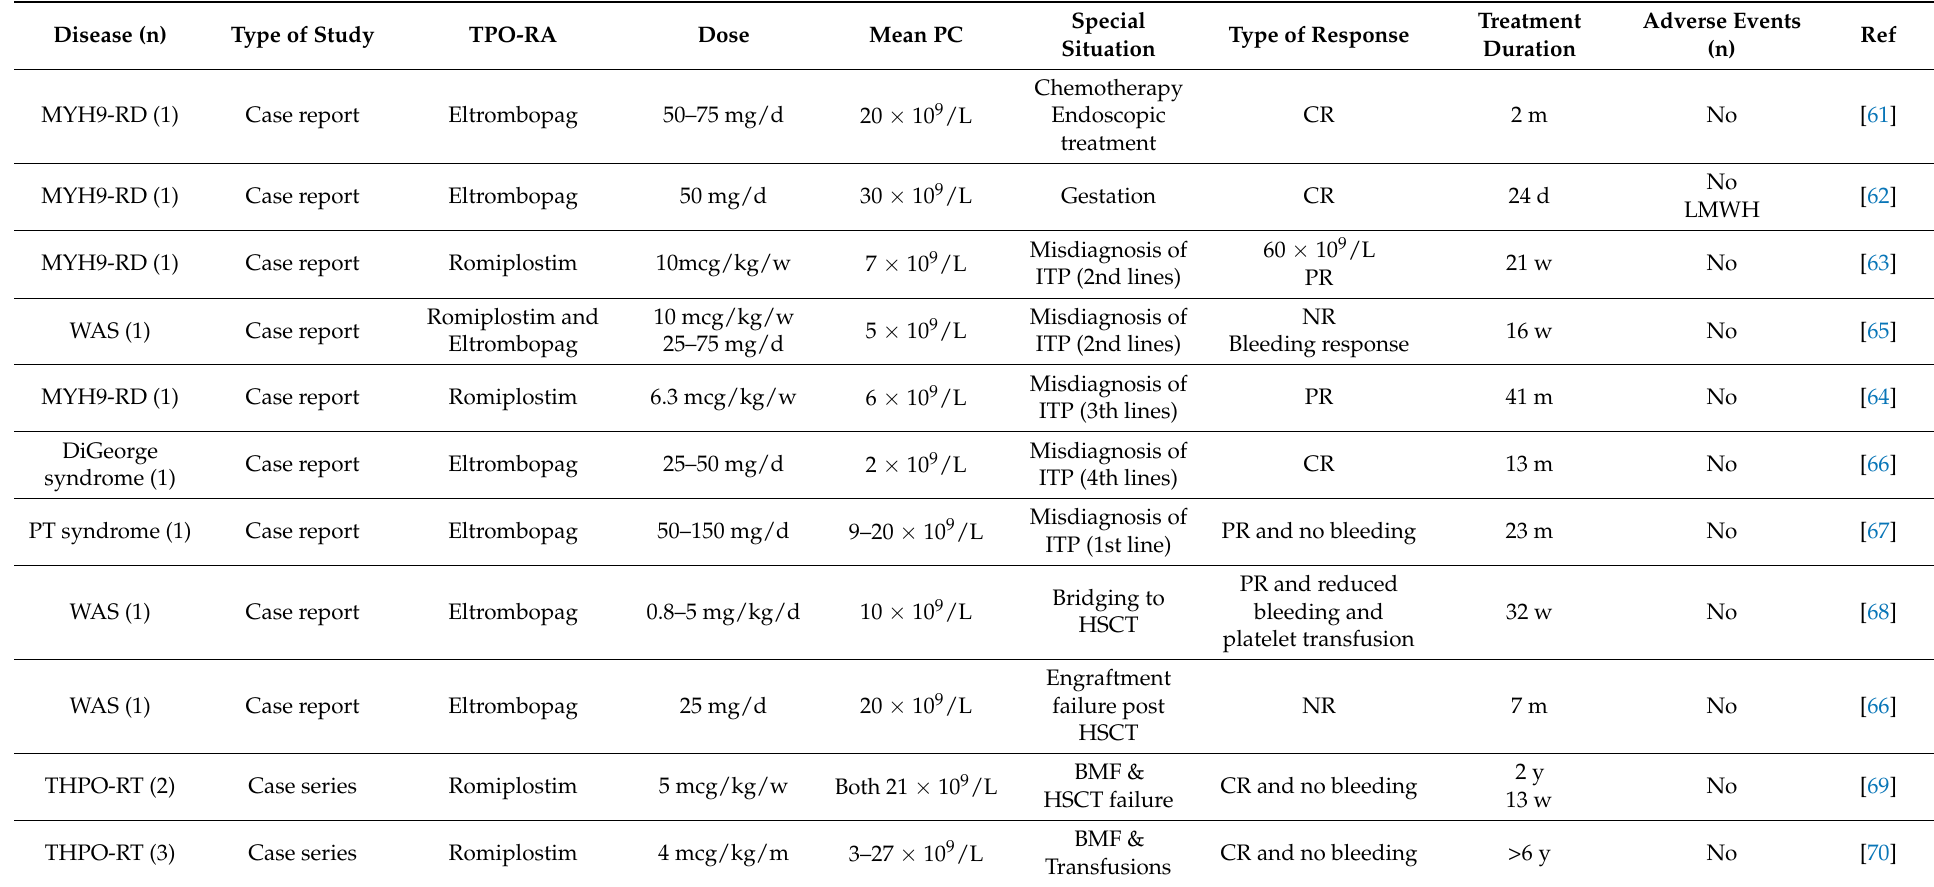
Table 4. Case reports and series of cases of patients with inherited thrombocytopenia treated with TPO-RA were used in special